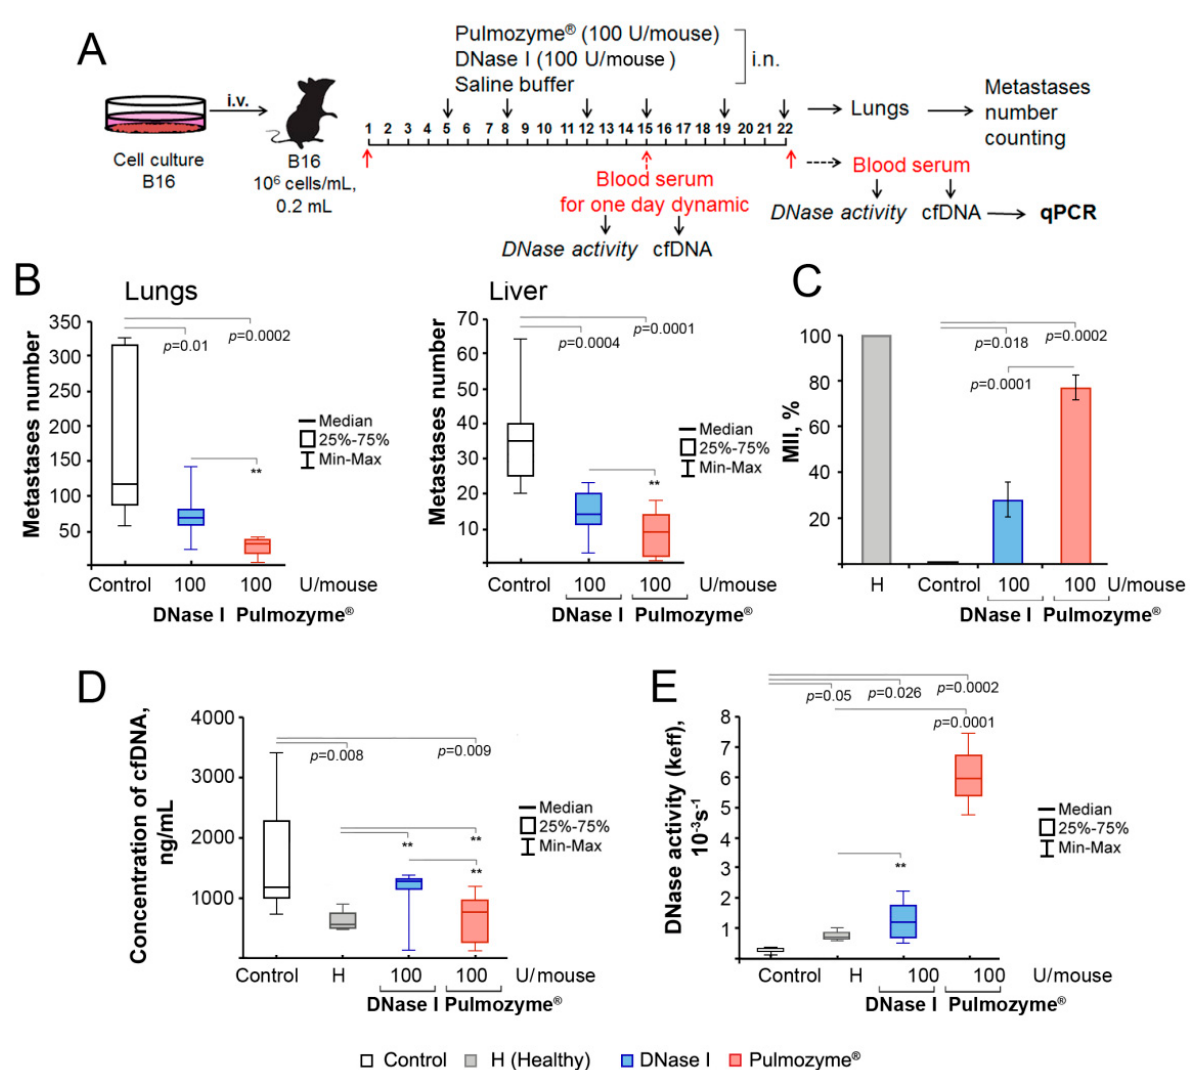
Figure 3. The effect of Pulmozyme ® and DNase I administered intranasally on metastases development, DNase activity and concentration of cfDNA in blood serum of mice with B16. ( A ) Scheme of the animal experiment. B16 cells (5 × 10 5 cells/mL, 0.2 mL) were implanted intravenously (i.v.) into C57Bl mice (male). Starting from day 5, animals received i.n. saline buffer, Pulmozyme ® (100 U/mouse) or DNase I (100 U/mouse) twice a week (six administrations). On days 15 and 22, 1 h after administration, blood sampling was performed. On day 22 after blood sampling, animals were euthanized and the lungs and liver were removed. cfDNA was isolated from blood serum and used for subsequent qPCR analysis. ( B ) Number of surface lung (left panel) and liver (right panel) metastases, respectively. ( C ) Metastasis inhibition index (MII) in lungs. Data are presented as mean ± SE. ( D ), ( E ) cfDNA and DNase activity of blood serum of mice with B16, respectively. Data are presented as median. Data were statistically analyzed using one-way ANOVA with a post hoc Tukey test. Statistical significance p < 0.05. **—statistically insignificant difference. Control group—columns/boxes outlined in black, H (healthy)—colored in grey, DNase I—blue, Pulmozyme ® —red.